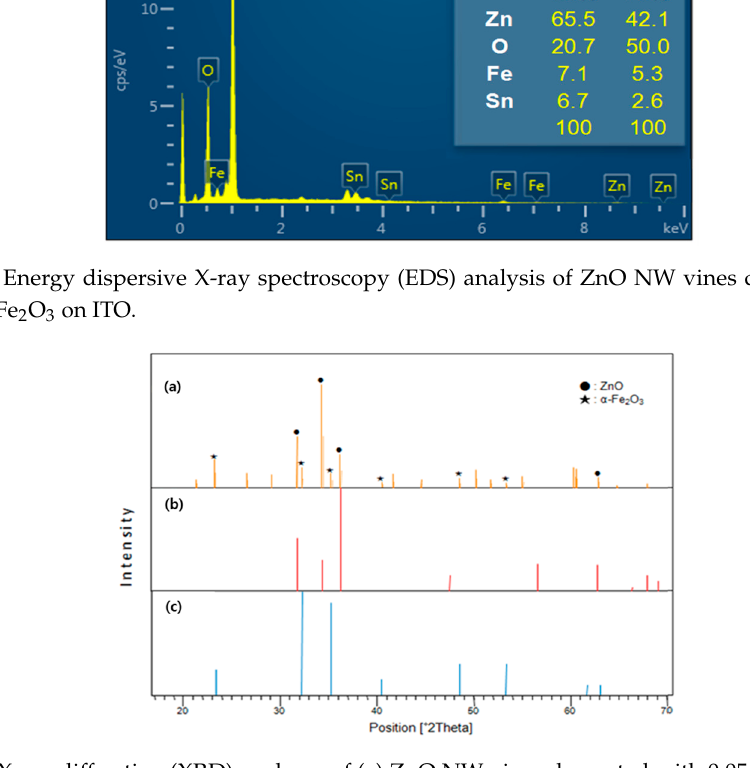
Figure 8. X-ray di ff raction (XRD) analyses of ( a ) ZnO NW vines decorated with 0.05-M α -Fe 2 O 3 on ITO, ( b ) hexagonal ZnO, ( c ) hematite α -Fe 2 O 3 .